Question: According to the figure, is the described quantity increasing or decreasing?
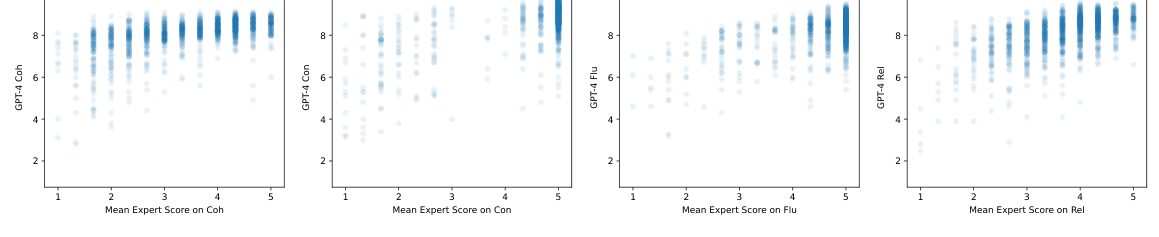
Answer: increasing